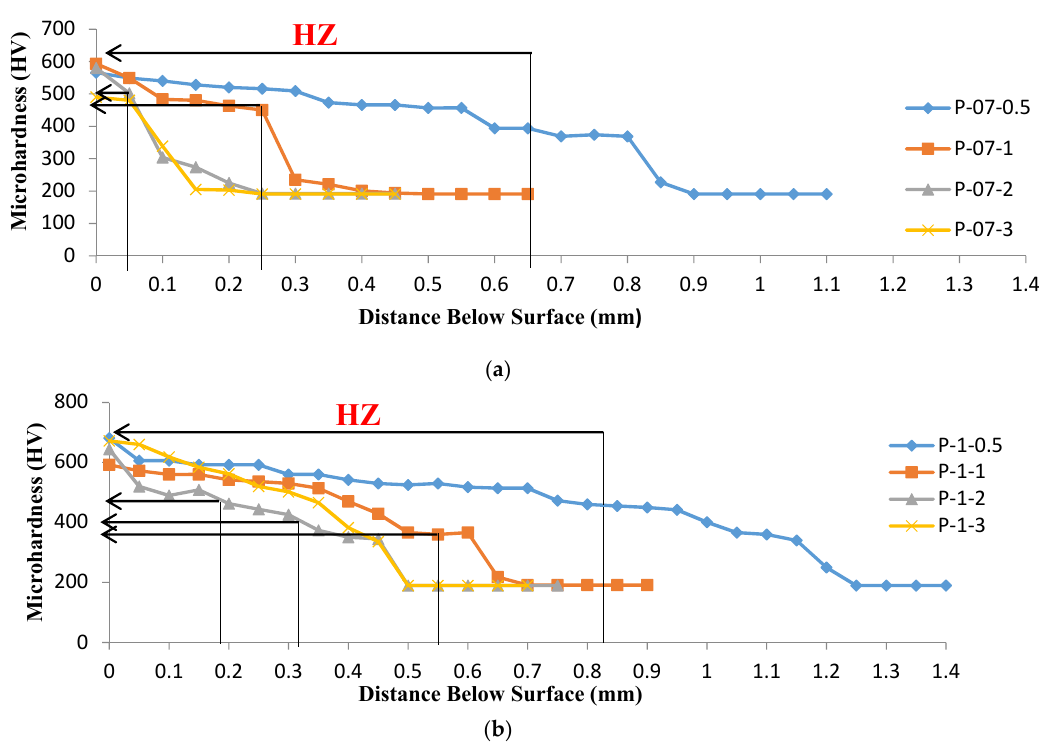
Figure 12. The microhardness profiles of the laser ‐ hardened specimens treated at laser powers of: ( a ) 700 W; and ( b ) 1000 W, corresponding to different laser scanning speeds (0.5, 1, 2 and 3 m ∙ min − 1 ).